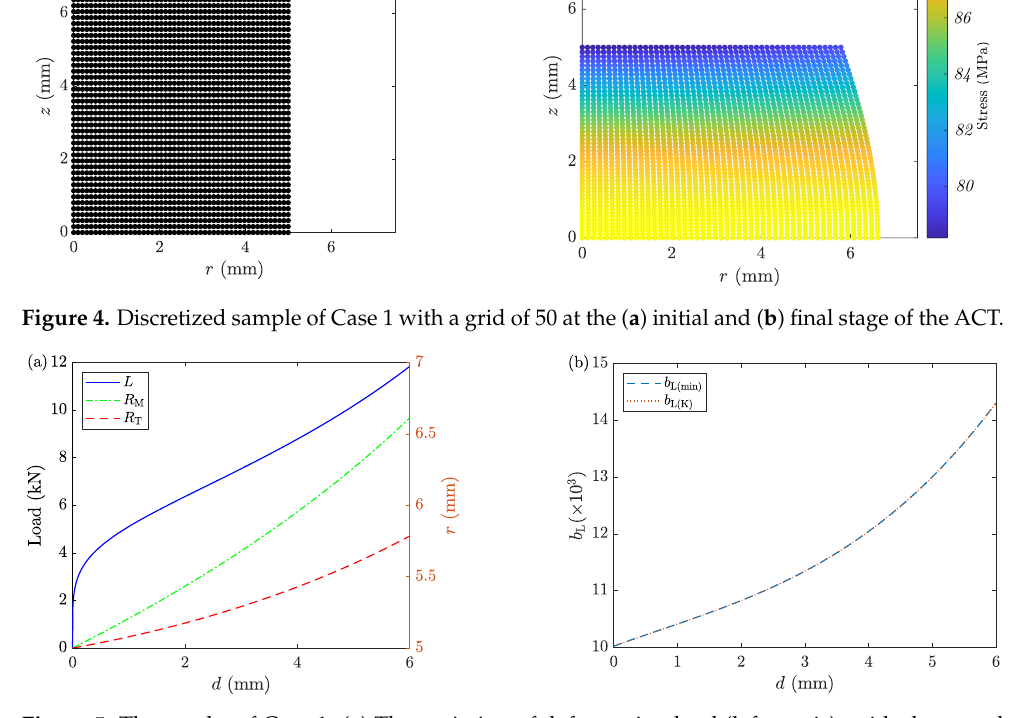
Figure 5. The results of Case 1. ( a ) The variation of deformation load (left y -axis), mid-plane, and top-plane radii (right y -axis) as functions of displacement d . ( b ) The values of b L obtained from the minimization process ( b L(min) ) and the kinematics estimation ( b L(K) ) from Equation